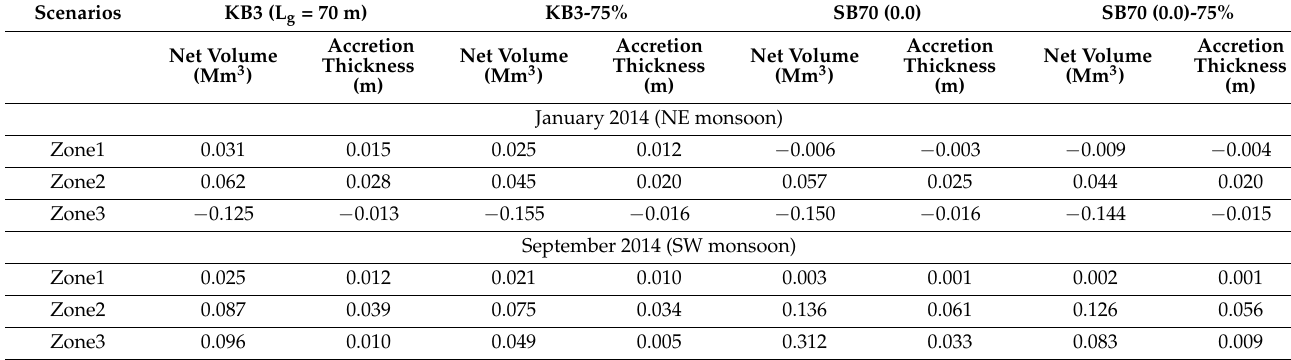
Figure 18. Morphological changes by MIKE21—comparison of breakwaters ( left ) (KB3) and sandbars ( right ) (SB70) for one month of the SW monsoon (September 2014). Table 6. Comparison of breakwater and sandbar impact by